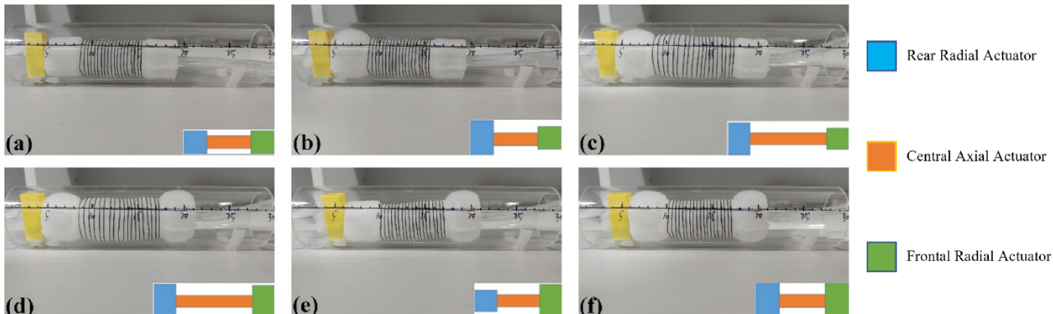
Figure 3. A movement cycle of the intestinal soft robot. ( a ) The initial state of the intestinal soft robot. ( b – f ) Five statuses during the movement. ( b – f ) Five statuses during the